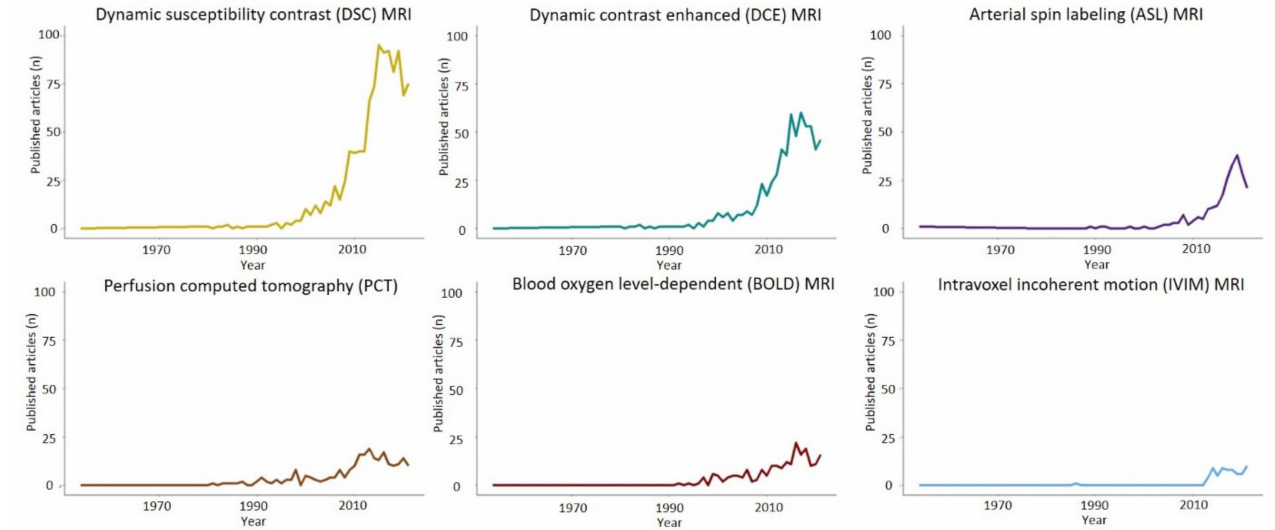
Figure 1. Publication per years of different hemodynamic imaging modalities and gliomas. DSC and DCE-MRI have been the subject of more intense research in glioma imaging, followed by ASL-MRI and PCT. IVIM-DWI and BOLD-CVR can also provide different hemodynamic information and in recent years are becoming the focus of active